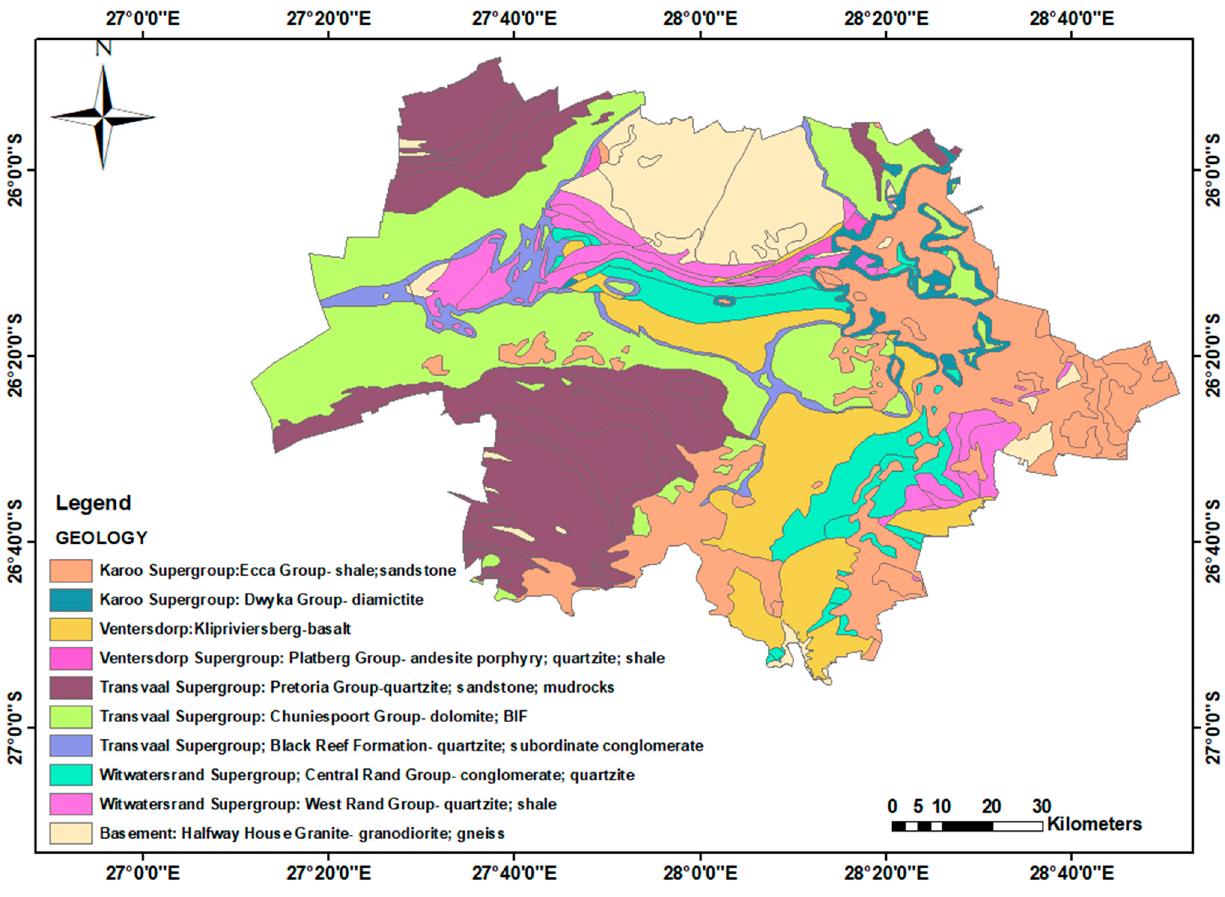
Figure 2. The geology map of the study area.